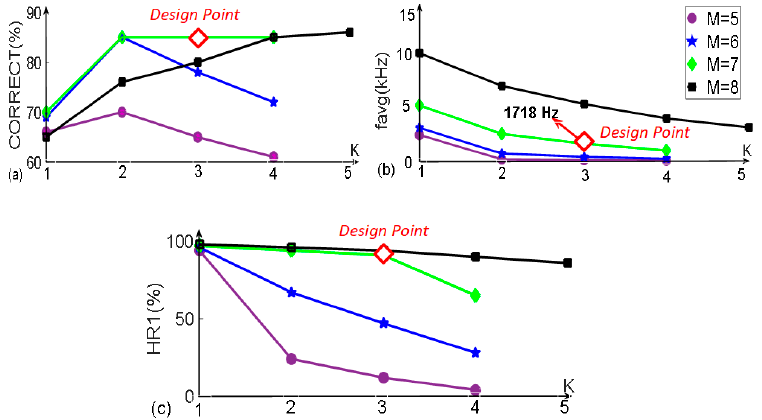
Figure 11. The results of the proposed LC-ADC-based VAD algorithm operation on the database signals to obtain optimized values for M and K. ( a ) The total performance metric (CORRECT) versus K. ( b ) The average sampling frequency (f avg ) versus K. ( c ) The speech hit rate (HR1) versus